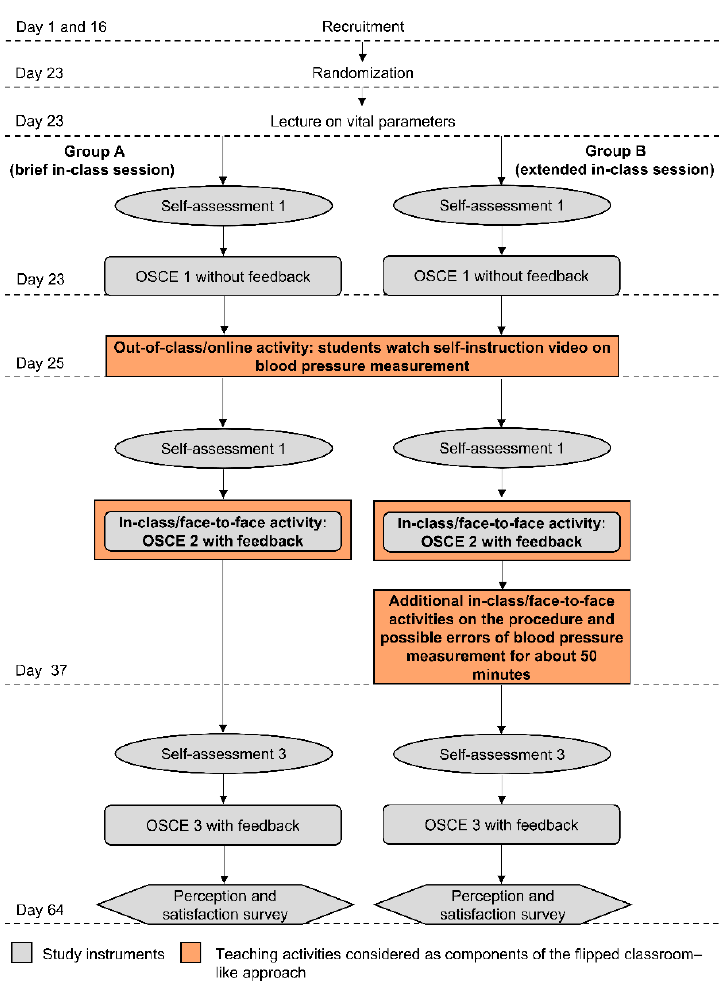
Figure 1. Overview of study design. OSCE = objective structured clinical examination.